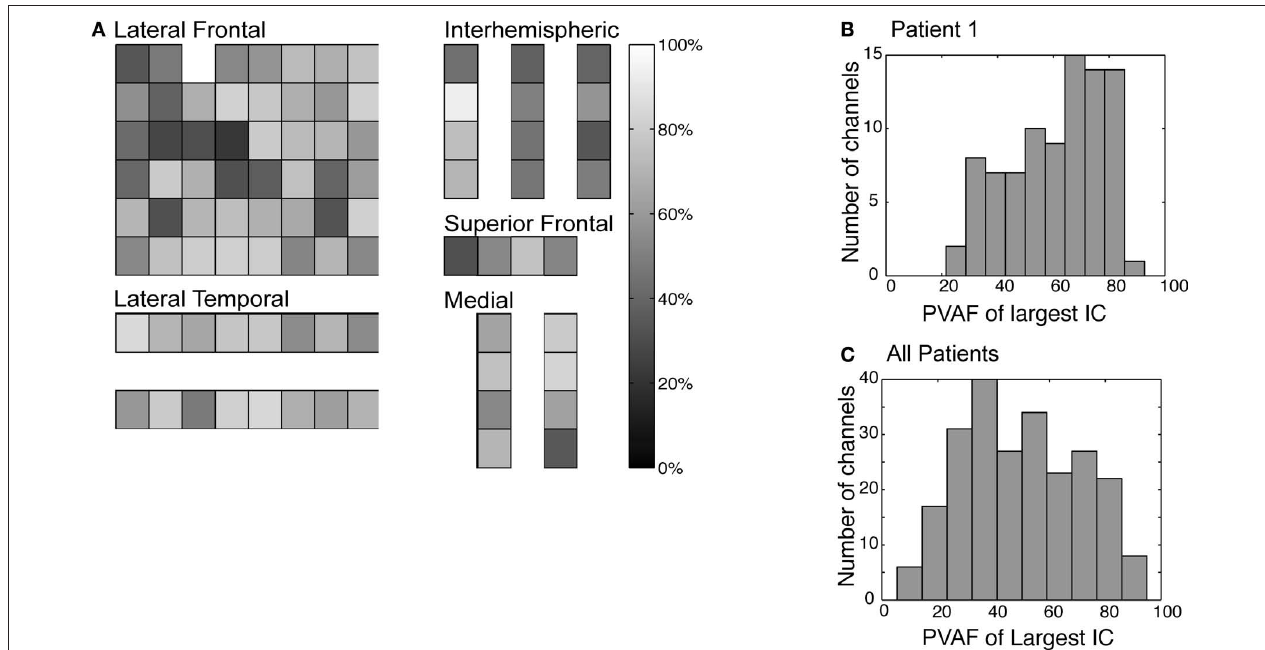
shown in white are dominated by a single independent component, whereas channels in dark gray are accounted for by a linear combination of multiple components. (B) Histogram of maximum percent variance of iEEG channels shown in (A) . A range of values is demonstrated. (C) Combined histogram of the percent variance of maximal independent component projection to each iEEG channel, across all four patients. The range in maximum percent variance accounted for (PVAF) is similar for all